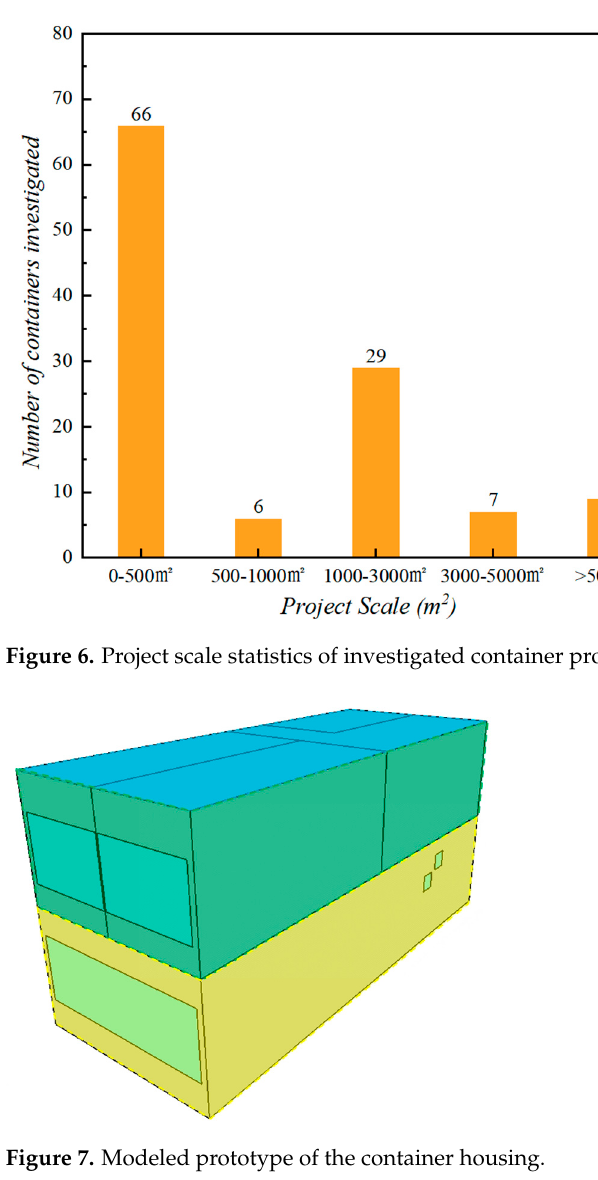
Figure 7. Modeled prototype of the container housing.